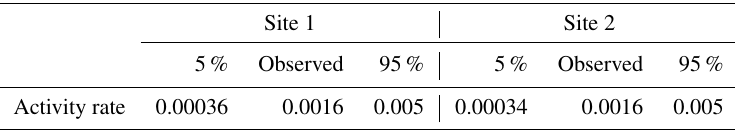
Table 3. Annual activity rates for the background near-site